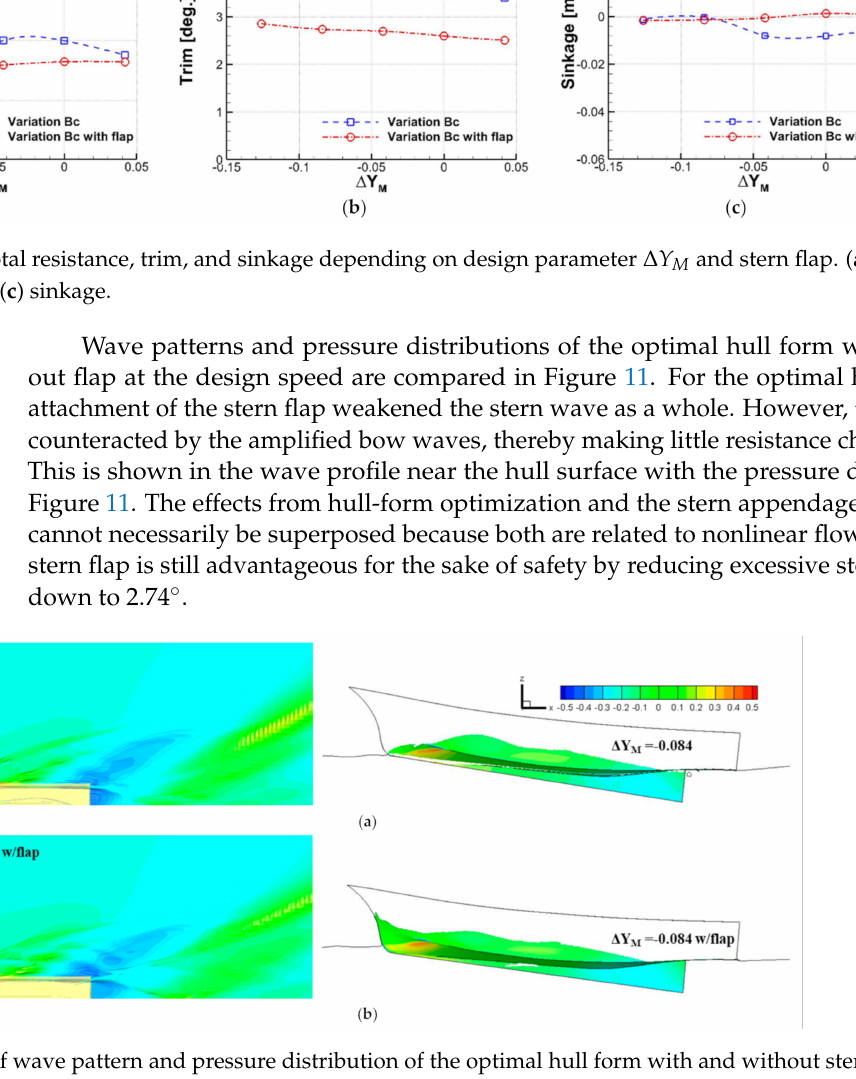
Figure 11. Comparison of wave pattern and pressure distribution of the optimal hull form with and without stern flap. ( a ) Optimal hull ( ∆ Y M = − 0.084) without stern flap; ( b ) optimal hull ( ∆ Y M = − 0.084 ) with stern